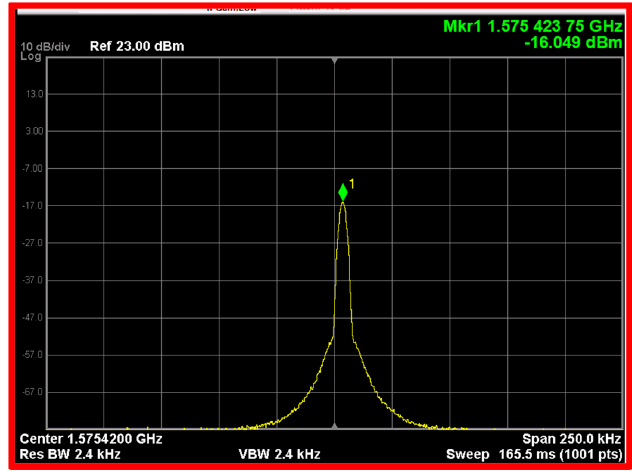
Figure 12. The spectrum of a Low Power CW Jamming Signal.